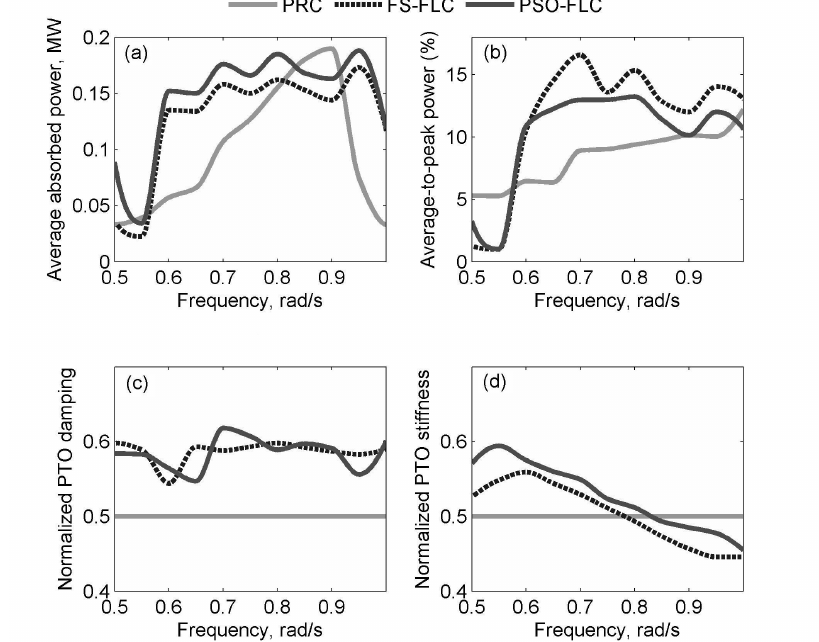
Figure 7. Comparison of the controllers performance for sea-states with H varying wave frequency ( a ) average absorbed power; ( b ) average-to-peak power ratio; ( c ) normalized PTO damping; ( d ) normalized PTO